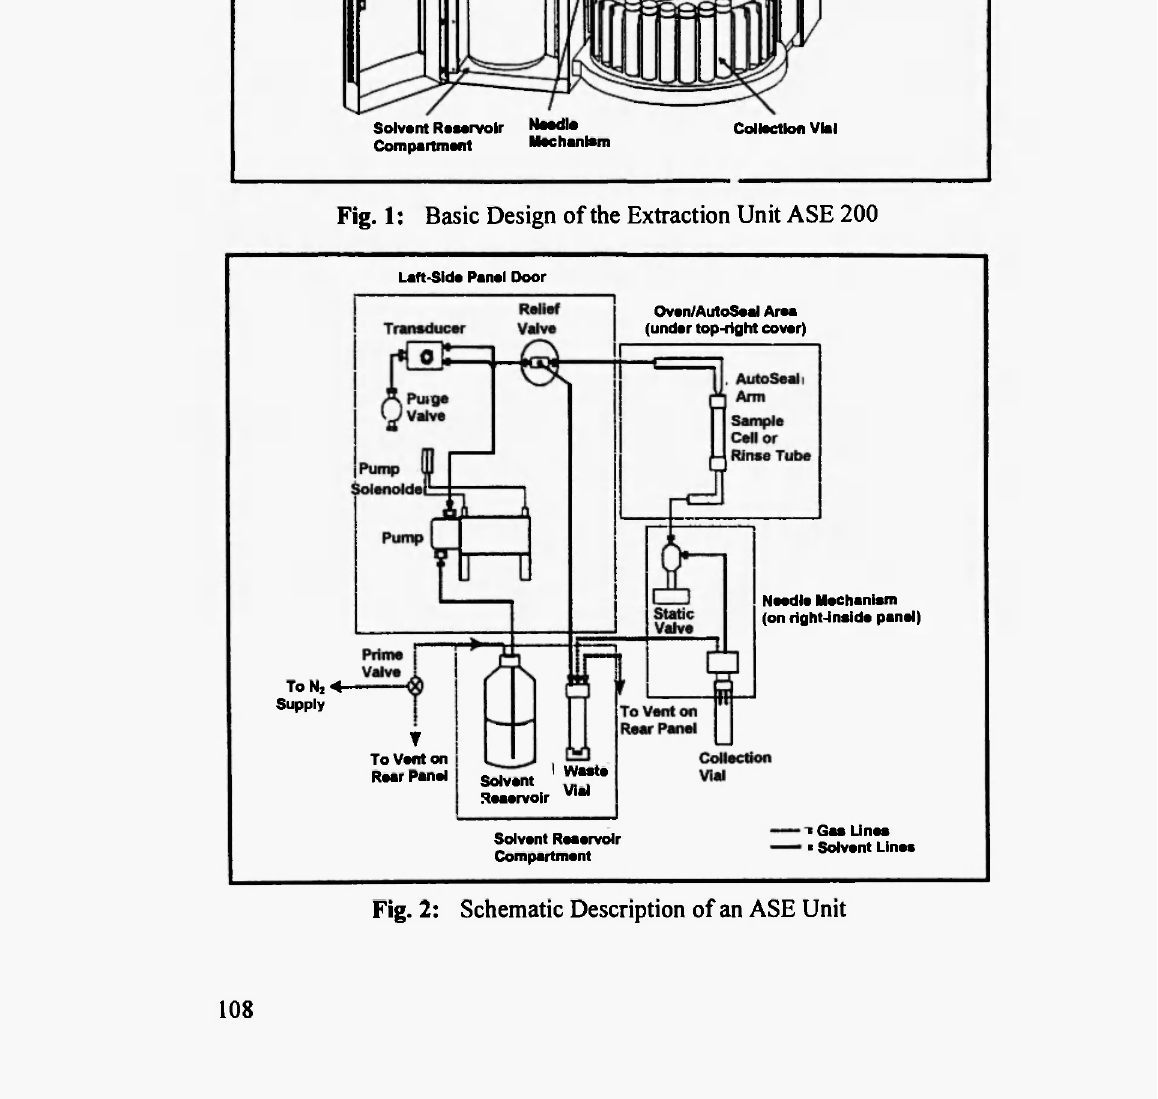
Fig. 2: Schematic Description of an ASE